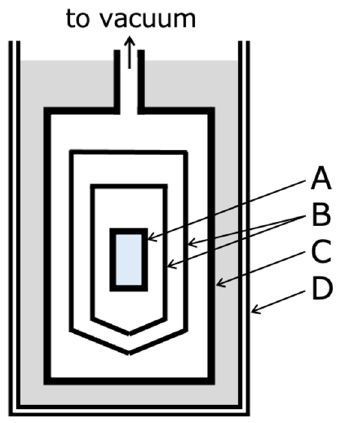
Figure 9. Schematic diagram of the adiabatic calorimeter cryostat used in this study. A: sample cell, B: double adiabatic shields, C: vacuum jacket, D: Dewar vessel. B: double adiabatic shields, C: vacuum jacket, D: Dewar